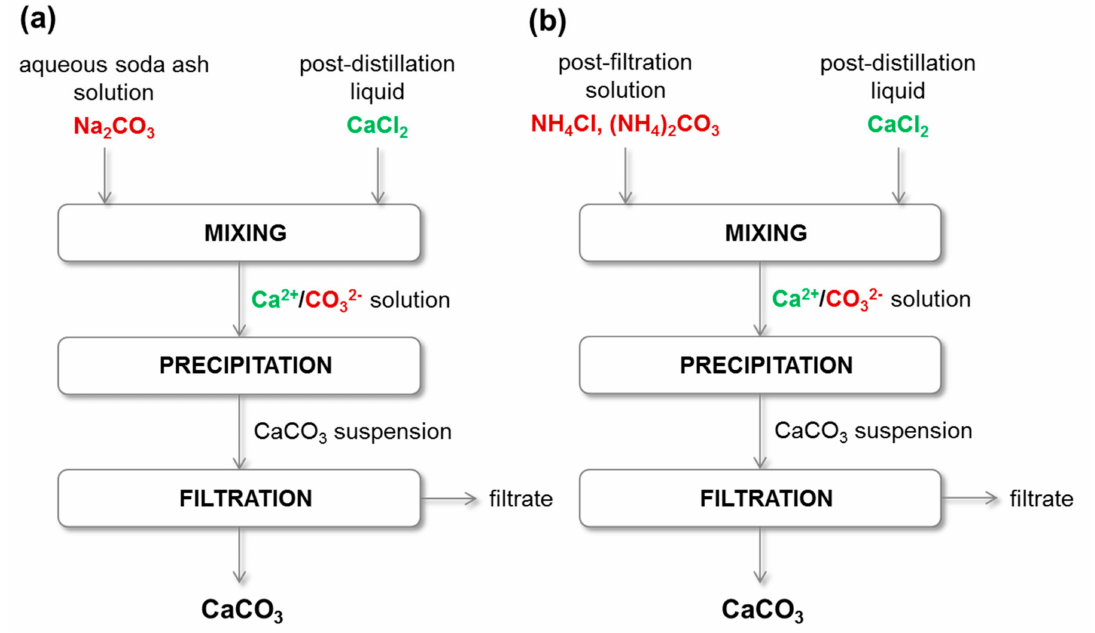
Figure 1. Diagram of the CaCO 3 precipitation process by the liquid-liquid method using post-distillation liquid and ( a ) an aqueous solution of Na 2 CO 3 or ( b ) post-filtration solution from the Solvay